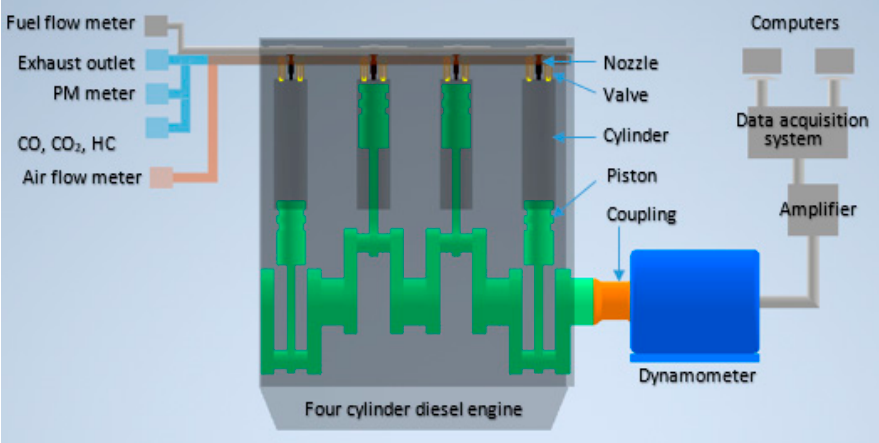
Figure 1. Schematic diagram of the experimental setup.